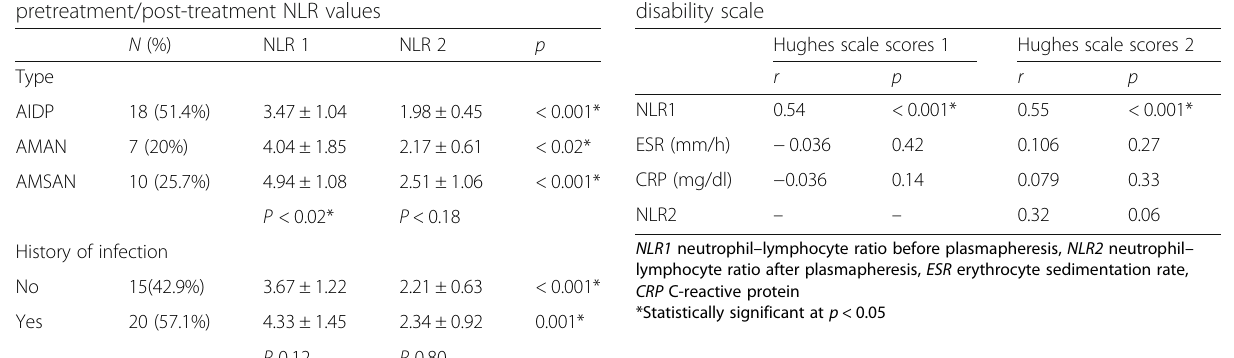
Table 4 Correlation between clinical parameter and